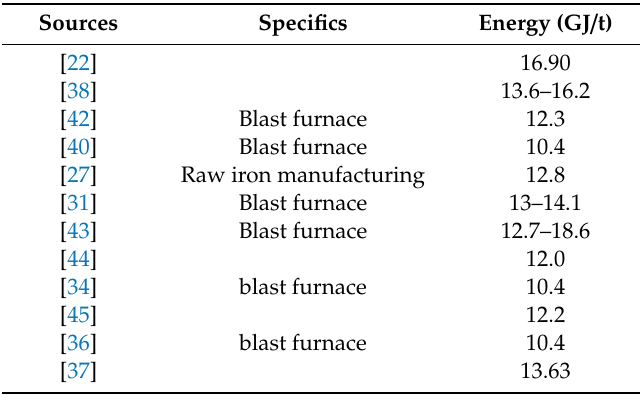
Table 9. Energy consumption per ton of limestone.